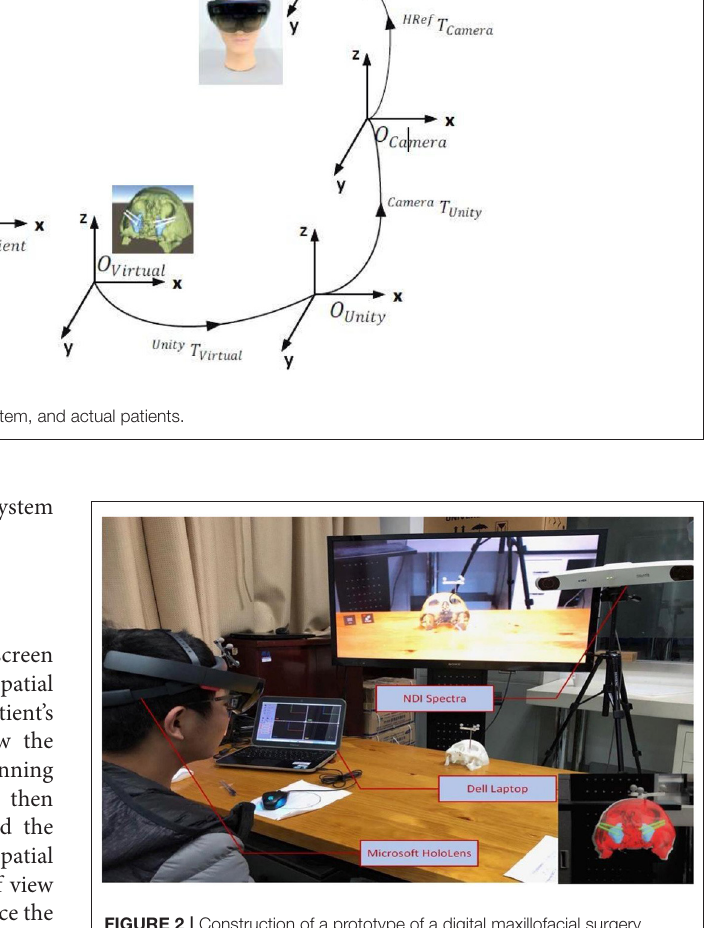
FIGURE 2 | Construction of a prototype of a digital maxillofacial surgery system based on mixed reality